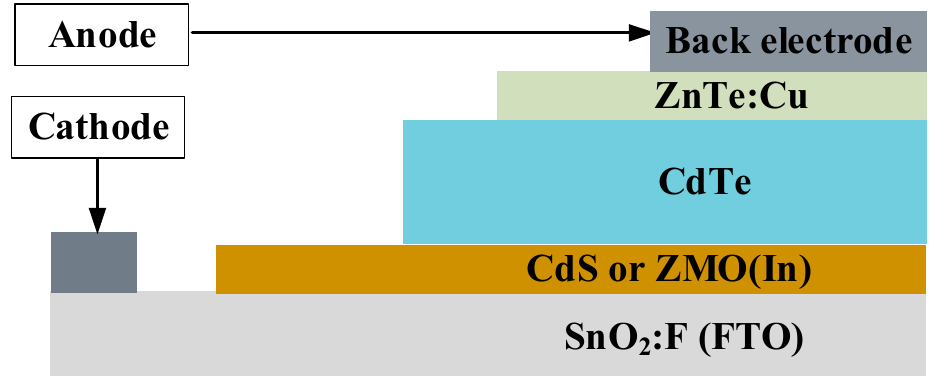
Figure 2. Device structure of CdTe solar cell for the device simulations.